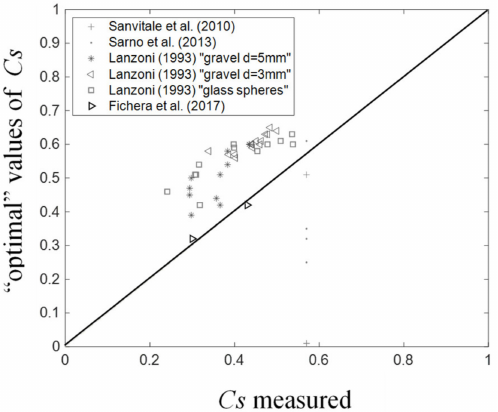
Figure 10. Comparison between the estimated “optimal” values of the parameter Cs and those measured and taken from the